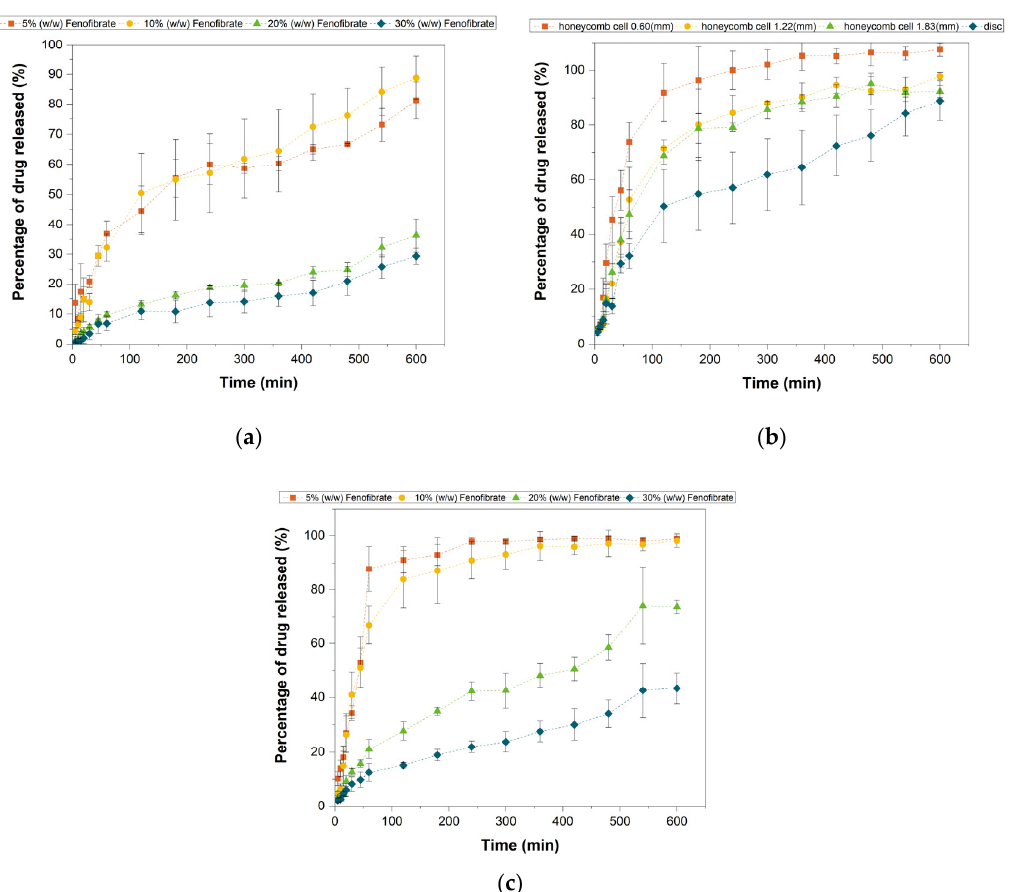
Figure 10. In vitro dissolution test of Sustained and Immediate release tablets. ( a ) Drug release from disc tablets with 100% infill and varying drug content, 5%, 10%, 20% and 30% w / w . ( b ) All tablet contained the same drug loading concentration of 10% w / w and varying infill, namely 17% ( ∅ cell = 1.83 mm), 24% ( ∅ cell = 1.22 mm), 45% ( ∅ cell = 0.60 mm) and 100% (disc tablets). ( c ) Tablets with 45% infill and cell diameter of 0.60 mm tested for different drug loading concentrations.